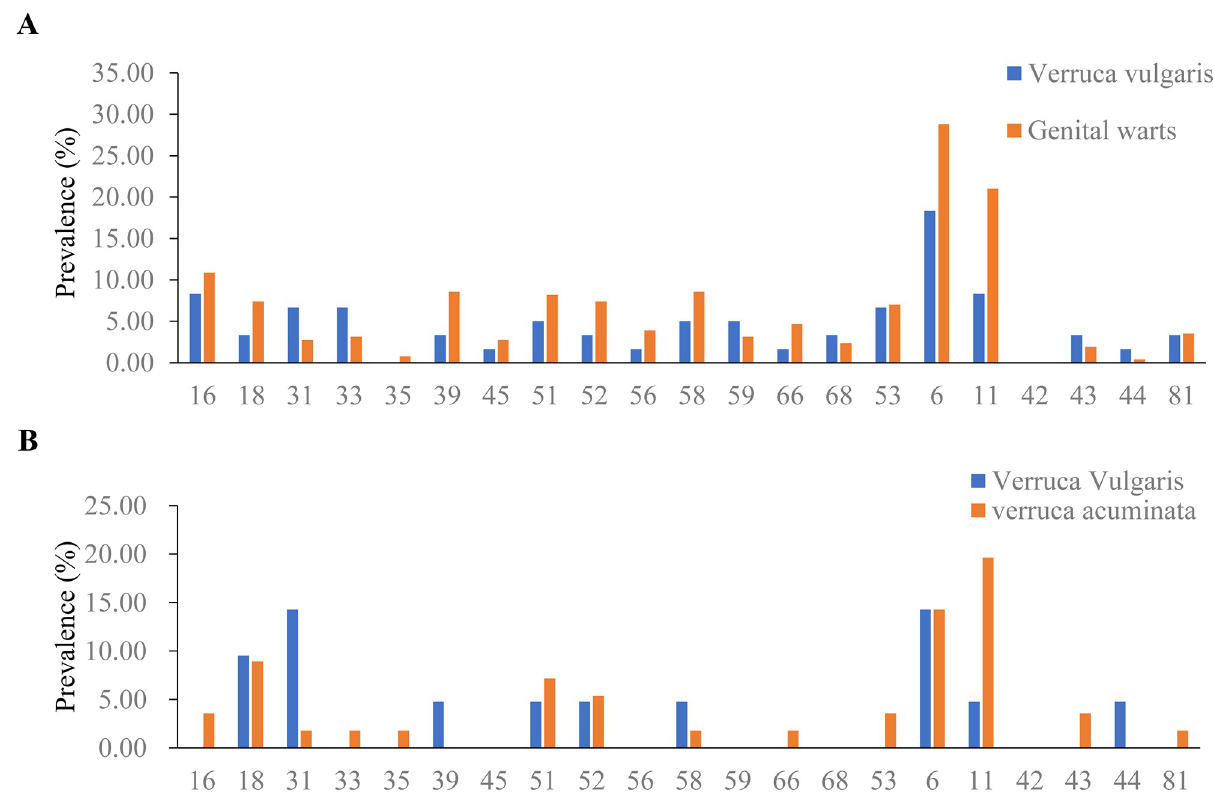
Fig 5. HPV prevalence associated with common warts and genital warts. (A) The HPV prevalence associated with common warts and genital warts in women. (B) The HPV prevalence associated with common warts and genital warts in